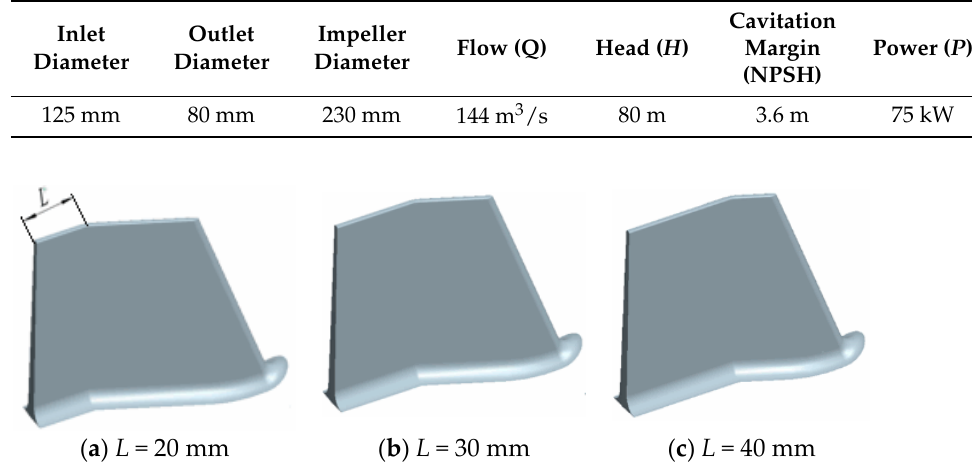
Figure 1. Models of the different L values of the